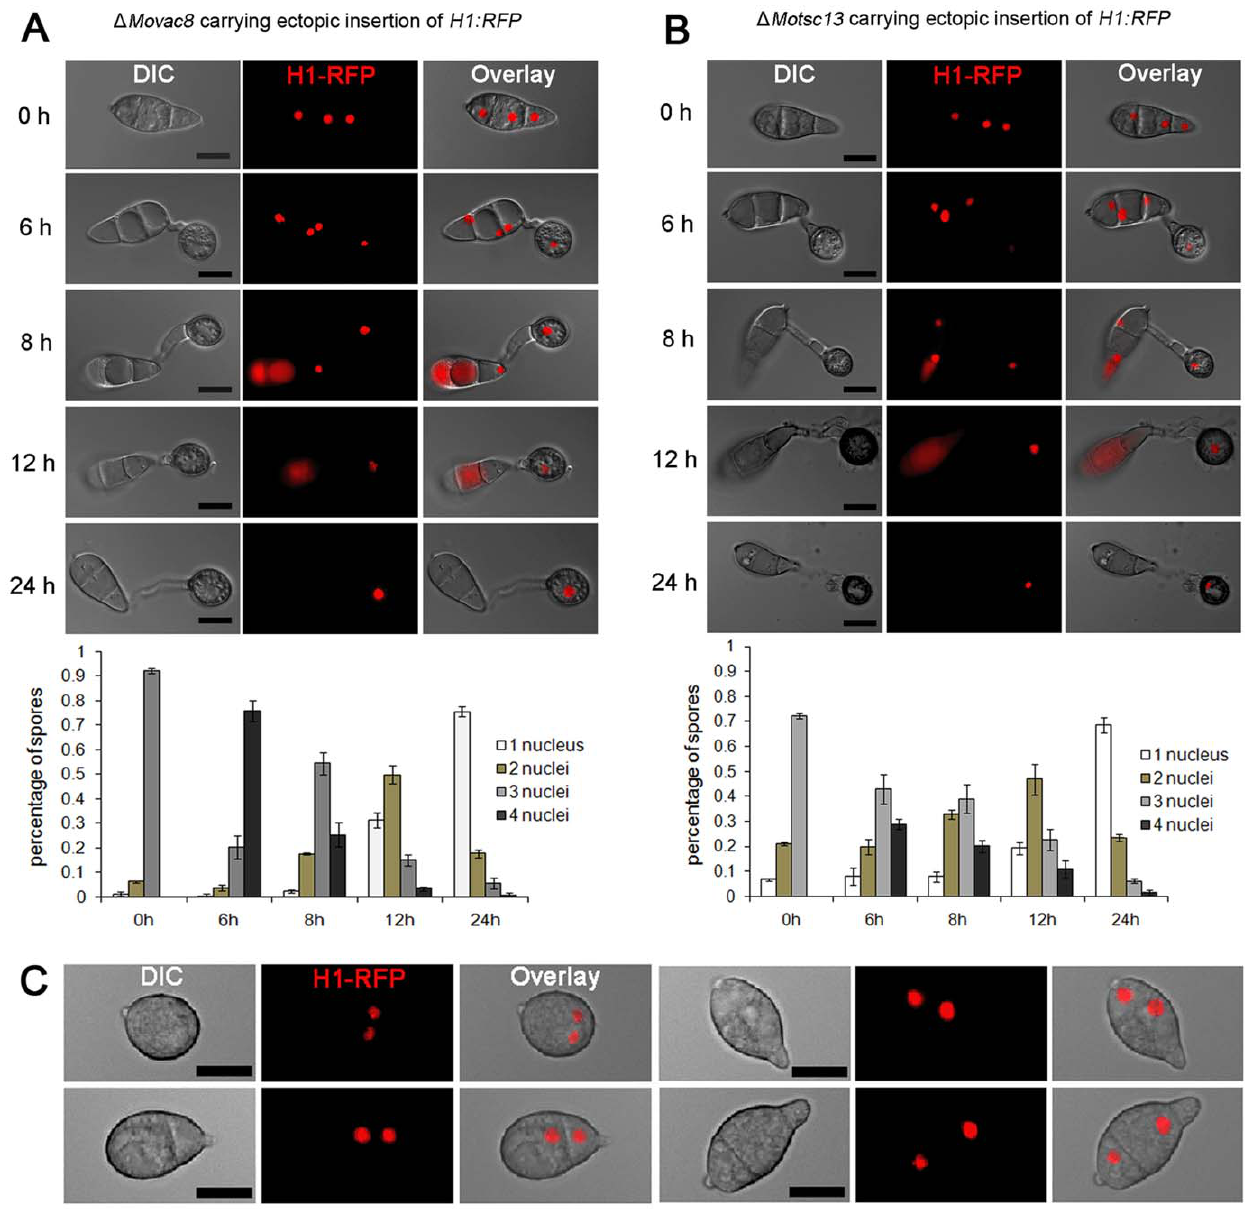
Figure 5. MoVAC8 and MoTSC13 are not required for nuclear degeneration in M.oryzae . ( A ) Nuclear degeneration during appressorium development occurs independently of MoVAC8 . Upper panel: time course live cell images showing nuclear division and nuclear degeneration during appressorium development in M. oryzae D Movac8 deletion mutants. D Movac8 expressing H1:RFP were examined by epifluorescence microscopy at indicated time points during appressorium development. Lower panel: time series of bar charts showing the percentage of spore germlings of D Movac8 containing between 0 and 4 nuclei (mean 6 SD, n . 100, triple replications). ( B ) Nuclear degeneration during appressorium development occurs independently of MoTSC13 . Upper panel: time course live cell images showing nuclear division and nuclear degeneration during appressorium development in M. oryzae MoTSC13 deletion mutants. D Motsc13 expressing H1:RFP were examined by epifluorescence microscopy at indicated time points during appressorium development. Lower panel: time series of bar charts showing the percentage of spores in D Motsc13 containing between 0 and 4 nuclei (mean 6 SD, n . 100, triple replications). ( C ) Micrographs showing abnormal conidia of D Motsc13 containing two nuclei. Scale bar=10 m